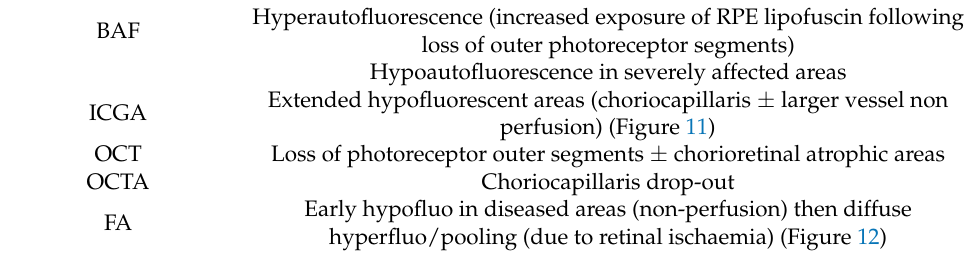
Table 3. Multimodal imaging of APMPPE/AMIC lesions and clinicopathological